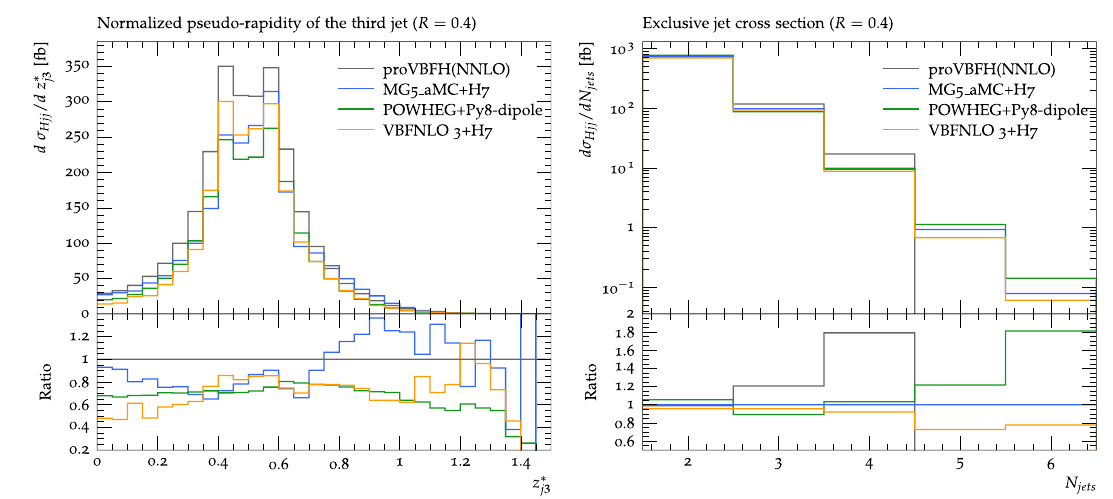
Fig. 13 Zeppenfeld variable of the third jet (left) and exclusive num- ber of jets (right) within the cuts of Eqs. (3)–(4) at NLO + PS accuracy for the MadGraph5_aMC@NLO , POWHEG-BOX , and VBFNLO + Her- wig7/Matchbox generators matched with HERWIG7 and PYTHIA8